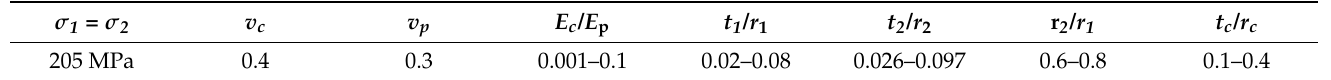
Table 1. Range of parameters used in deterministic